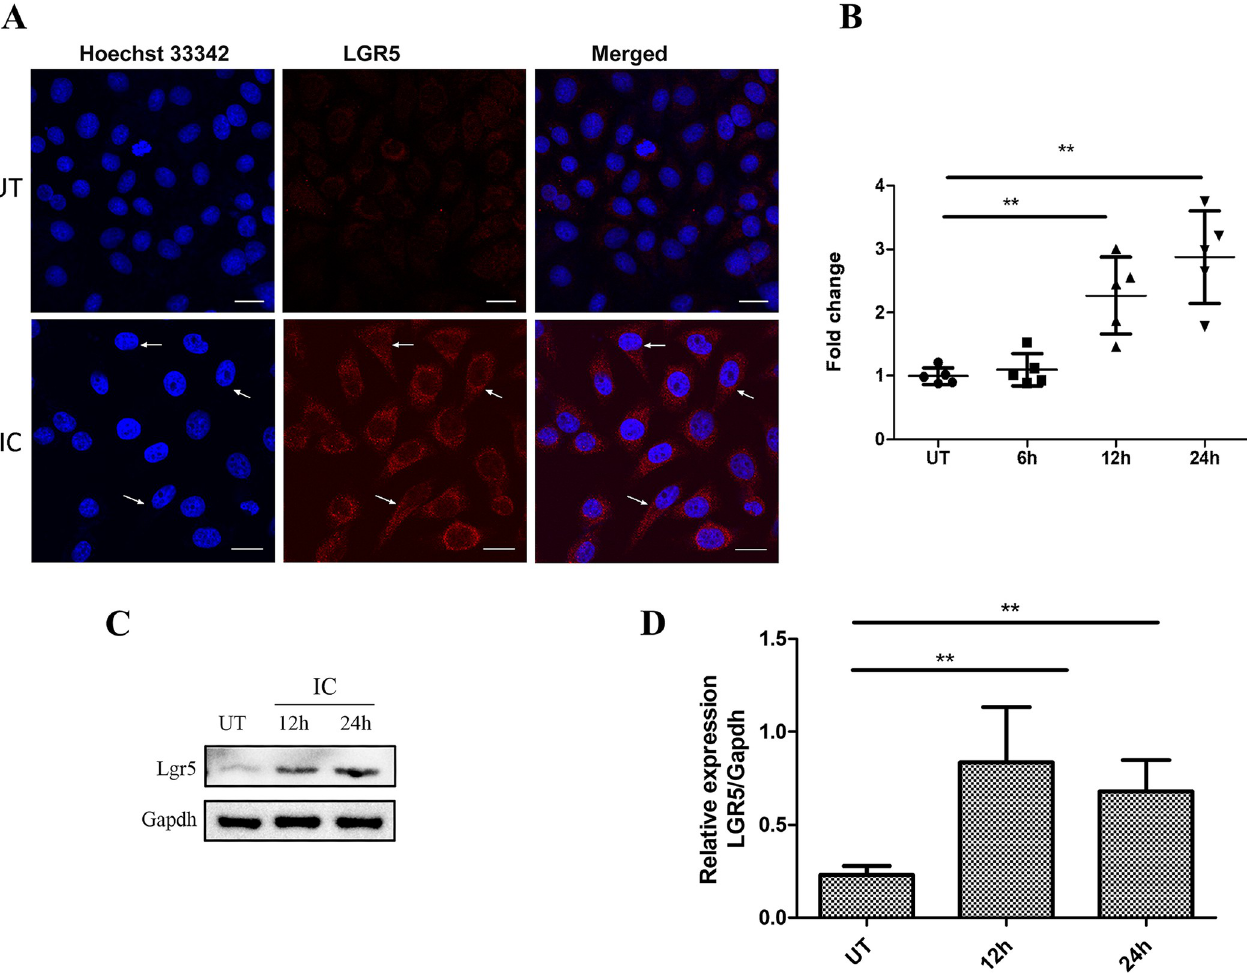
Fig 2. The inflammatory condition affects LGR5 expression in FaDu cells. A: Representative imaging of LGR5 expression in FaDu cells by immunofluorescence assay. FaDu cells stained for Hoechst 33342 (blue) and LGR5 (red) after treatment with the inflammatory condition or control group are shown. The arrows indicate FaDu cells with stromal-like phenotypic changes. Scale bar = 20 μ m. B: The expression level of LGR5 in FaDu cells was analyzed by reverse transcription-quantitative PCR after 6, 12, and 24 hours of treatment with the inflammatory condition. C-D: The experimental group was treated with the inflammatory condition for 12 and 24 hours. Western blotting was used to analyze LGR5 expression in FaDu cells. Quantification (D) and representative blots (C) are shown. Statistical significance is denoted by �� P < 0.01. UT: untreated group; IC: inflammatory